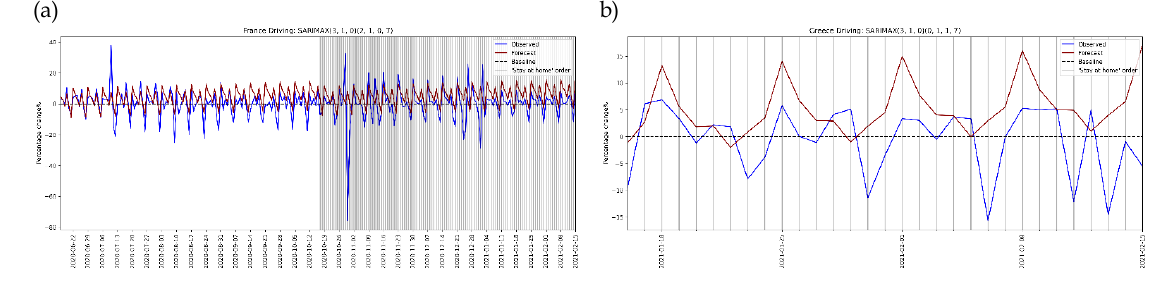
Figure 8. SARIMAX forecasts for walking in relation to school closing (a: Austria, b: Czech Republic, c: Denmark, d: Hungary, e: Italy, f: Portugal, g: Romania, h: